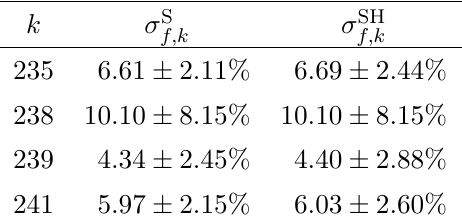
) in ref. [65]. The f;k